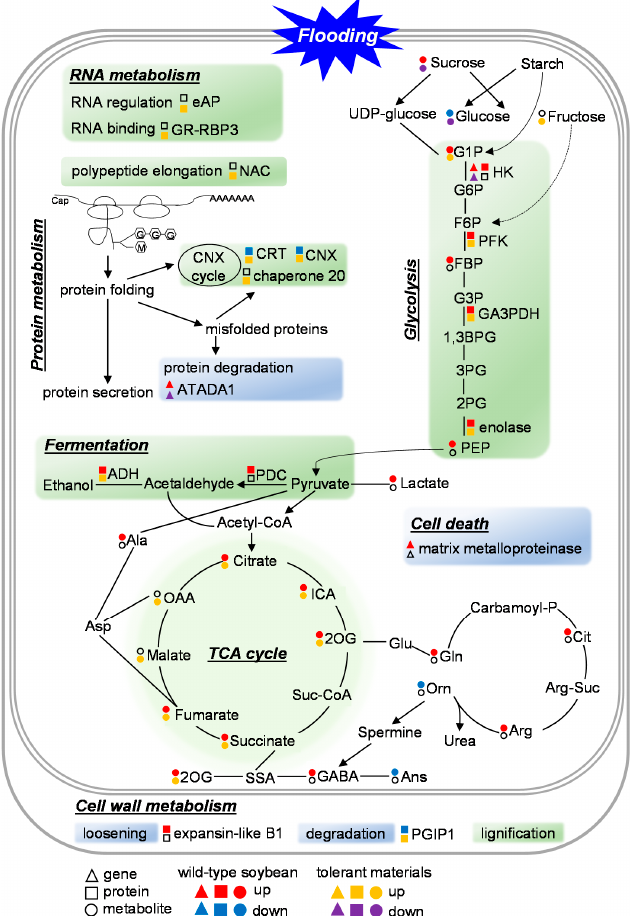
Figure 1. Di ff erences between response and tolerant mechanisms against flooding stress. Scheme of core cellular pathways between response and tolerance in root of early-stage soybean in response to flooding stress is summarized based on plant omics data collected from wild-type soybean and flood-tolerant materials. Triangle, box, and circle indicate gene, protein, and metabolite, respectively. Red and blue colors indicate up- and down-regulation of gene / protein / metabolite in flooded wild-type soybean compared with untreated plant, respectively. Orange and purple colors indicate up- and down-regulation of gene / protein / metabolite in flood-tolerant materials compared with wild-type soybean under flooding, respectively. Gene, protein, and metabolite in black color mean the alteration induced by flooding stress is not clear. Green and blue colors indicate activation and suppression of metabolism in flood-tolerant materials compared with wild-type soybean under flooding. Abbreviations: 1,3BPG, glycerate 1,3-bisphosphate; 2OG, 2-oxoglutarate; 2PG, 2-phospho-glycerate; 3PG, 3-phospho-glycerate; ADH, alcohol dehydrogenate; Ala, alanine; Ans, anserine; Arg, arginine; Arg-Suc, arginino-succinate; Asp, aspartic acid; ATADA1, ATPase family AAA domain containing protein 1; Cit, citrulline; CNX, calnexin; CRT, calreticulin; eAP, eukaryotic aspartyl protease; FBP, fructose 1,6-bisphosphate; G, glucose; G1P, glucose 1-phosphate; G3P, glyceradehyde 3-phosphate; G6P, glucose 6-phosphate; GA3PDH, glyceraldehyde 3-phosphate dehydrogenase; GABA, gamma-aminobutyric acid; Gln, glutamine; Glu, glutamic acid; GR-RBP3, glycine-rich RNA-binding protein 3; HK, hexokinase; ICA, isocitrate; M, mannose; NAC, nascent polypeptide-associated complex; OAA, oxaloacetate; Orn, ornithine; PGIP1, polygalacturonase-inhibiting protein 1; PDC, pyruvate decarboxylase; PEP, phosphoenopyruvate; PFK, phosphofructokinase; SSA, succinate semialdehyde; Suc-CoA, succinyl-coenzyme